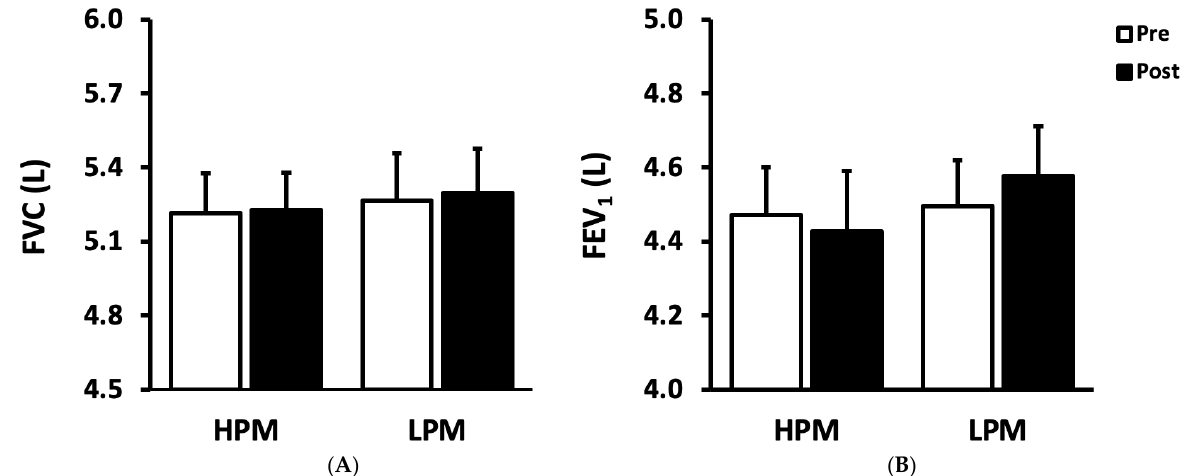
Figure 1. FVC (panel A ) and FEV 1 (panel B ) at pre- and post-exercise intervention. Data are mean ± standard error. FVC, forced vital capacity; FEV 1 , forced expiratory volume in 1 s; HPM, high PM 2.5 condition; LPM, low PM 2.5 condition. p ≥ 0.50 for time-condition interaction.